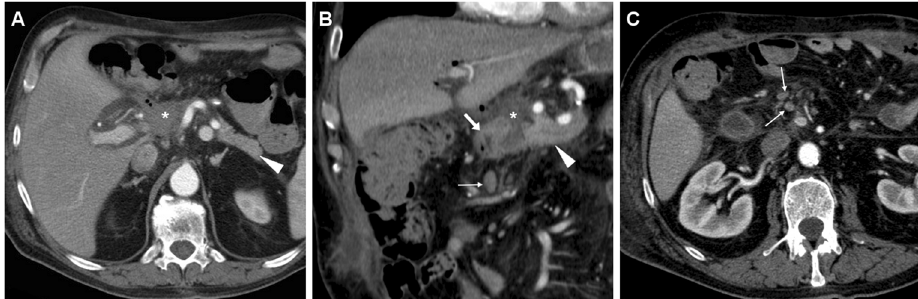
Fig. 5 a-c Postoperative pancreatic fistula (PF) after Whipple PD for pT3N1 pancreatic ductal adenocarcinoma in a 72-year-old man with persistent output and increasing amylase levels in fluid from drainage. On postoperative day 9, CT (Fig.3) showed a mixed-attenuation collection (*) extending upwards from the PJS, between the PR